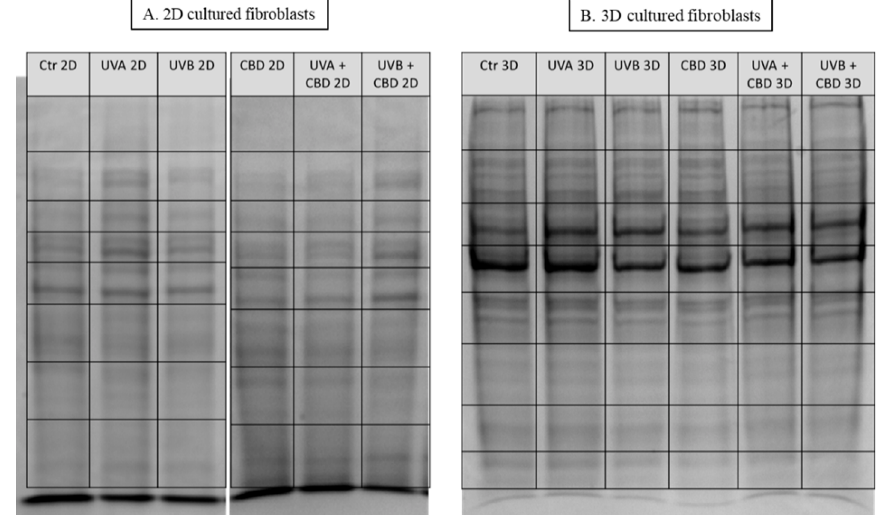
Figure 1. SDS-PAGE separation and staining with Coomassie Brilliant Blue R-250 of proteins from control skin fibroblasts and irradiated with UVA (20 J/cm 2 ), UVB (200 mJ/cm 2 ) or/and treated with cannabidiol (CBD, 4 μ M) in two-dimensional (2D) ( A ) or three-dimensional (3D) culture model ( B ). The grid indicates the borders of the protein migration zones.